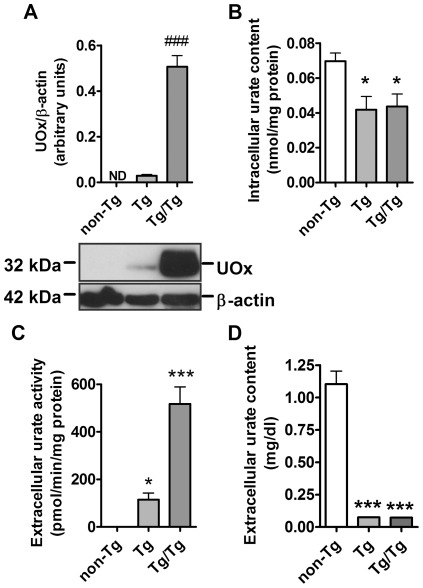
Characterization of non-Tg, Tg and Tg/Tg cortical astrocyte-enriched cultures.
A) Western blot and graph showing UOx immunostaining in non-Tg and UOx-expressing astrocytes (Tg and Tg/Tg) normalized to the β-actin level. Note that UOx was not detected in non-Tg astrocytes (n = 7). B) Effect of UOx expression on the intracellular urate content normalized to the protein level (n = 5). C) UOx activity in the media of non-Tg and UOx-expressing astrocytes (n = 9). D) Effect of UOx expression on extracellular urate concentration in astroglial cultures (n = 6). Some error bars are not visible because of their small size. Student's t test: ###
P<0.0001 vs Tg value. One-way ANOVA followed by Newman-Keuls test: *P<0.05, ***P<0.001 vs non-Tg value.